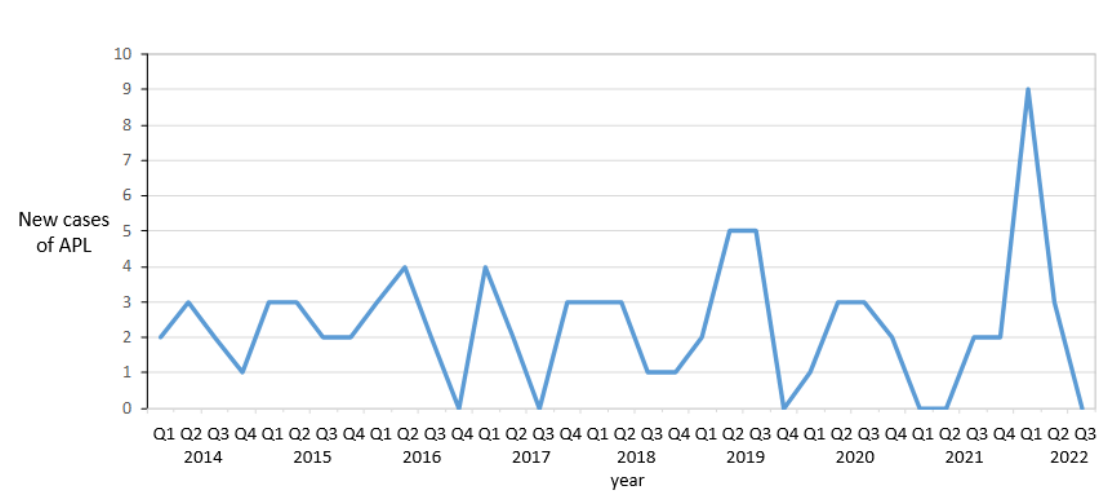
Figure 1: Quarterly incidence of newly diagnosed acute promyelocytic leukemia (APL) from Q1 2014 to Q3